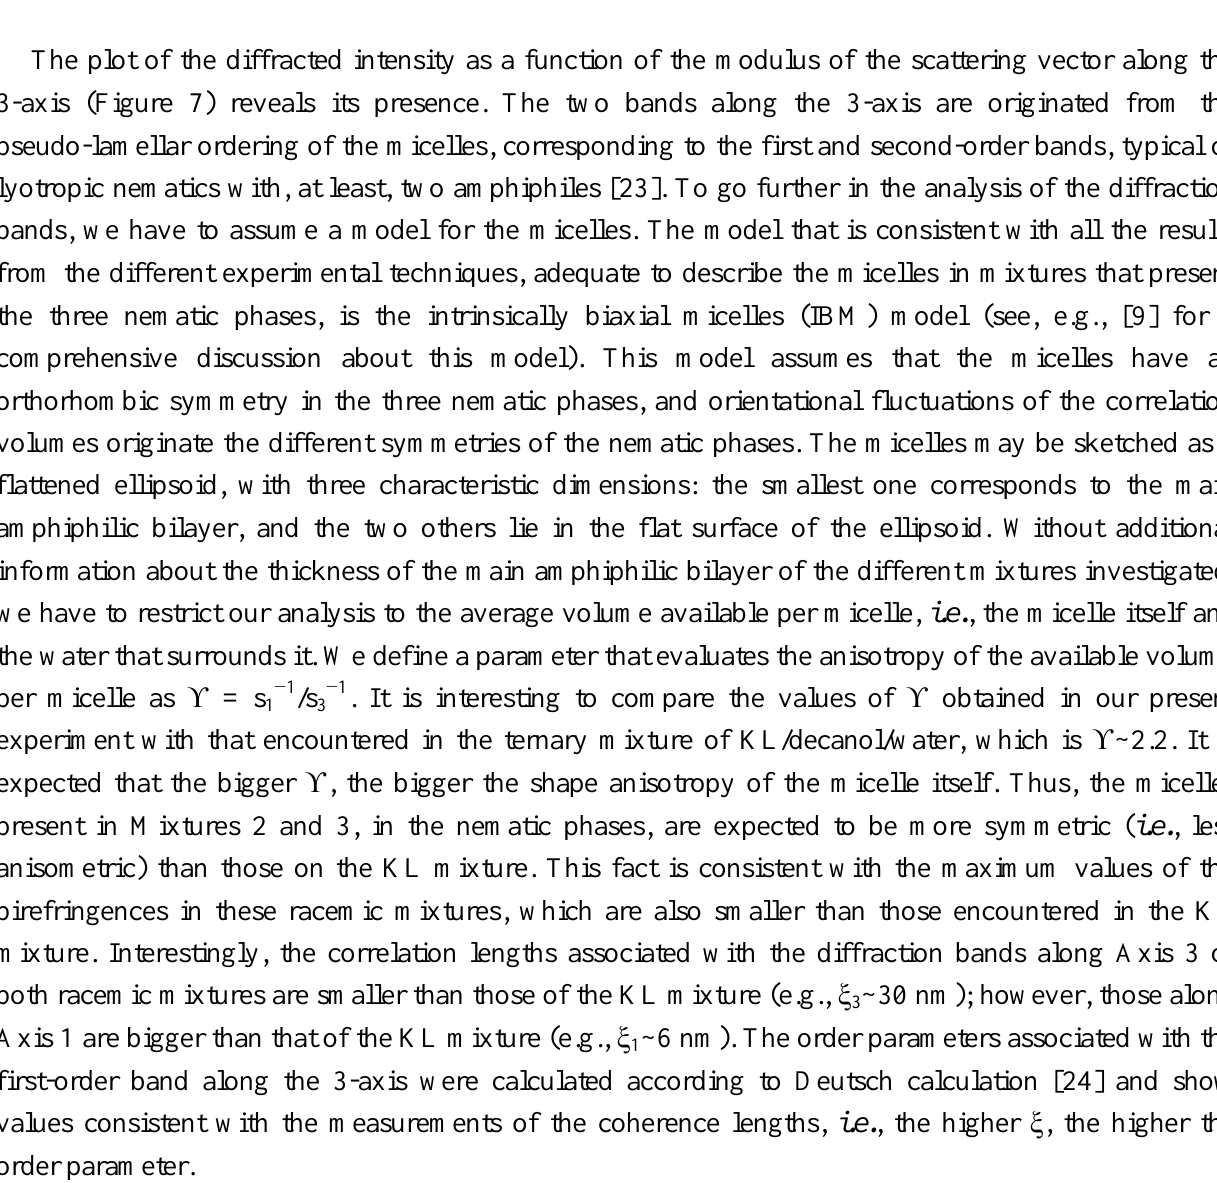
Figure 7. Diffracted intensity (in logarithmic scale) as a function of the modulus of the scattering vector along the 3-axis. Mixture DL -KDDS/Na T = 36.0 °C. The arrow indicates the location of the second-order